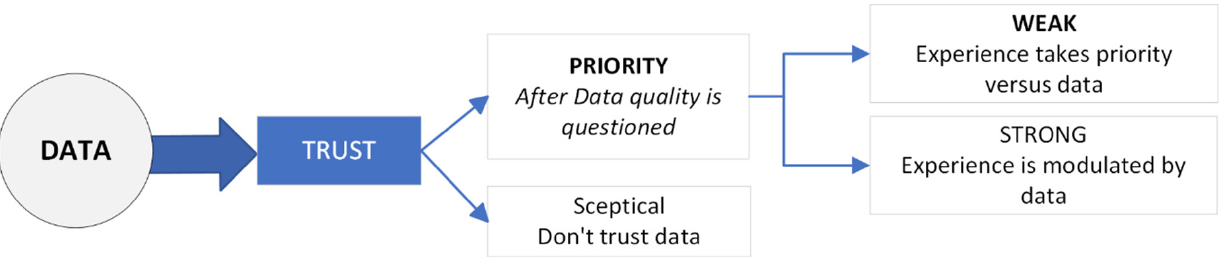
Figure 2. Data confidence.